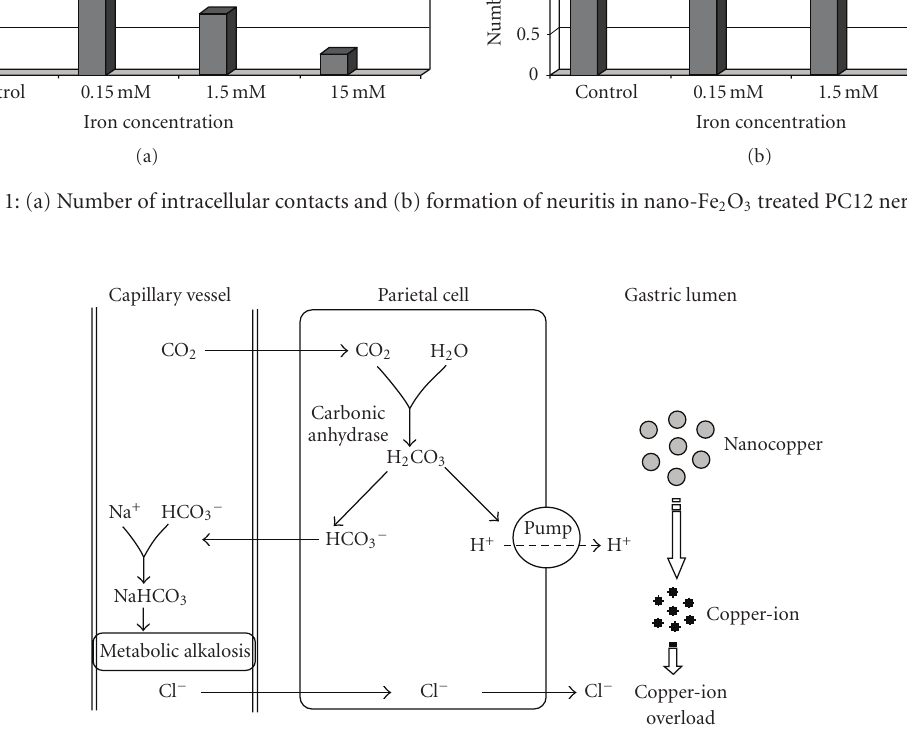
Figure 2: Mechanism of metabolic alkalosis induced by nanocopper